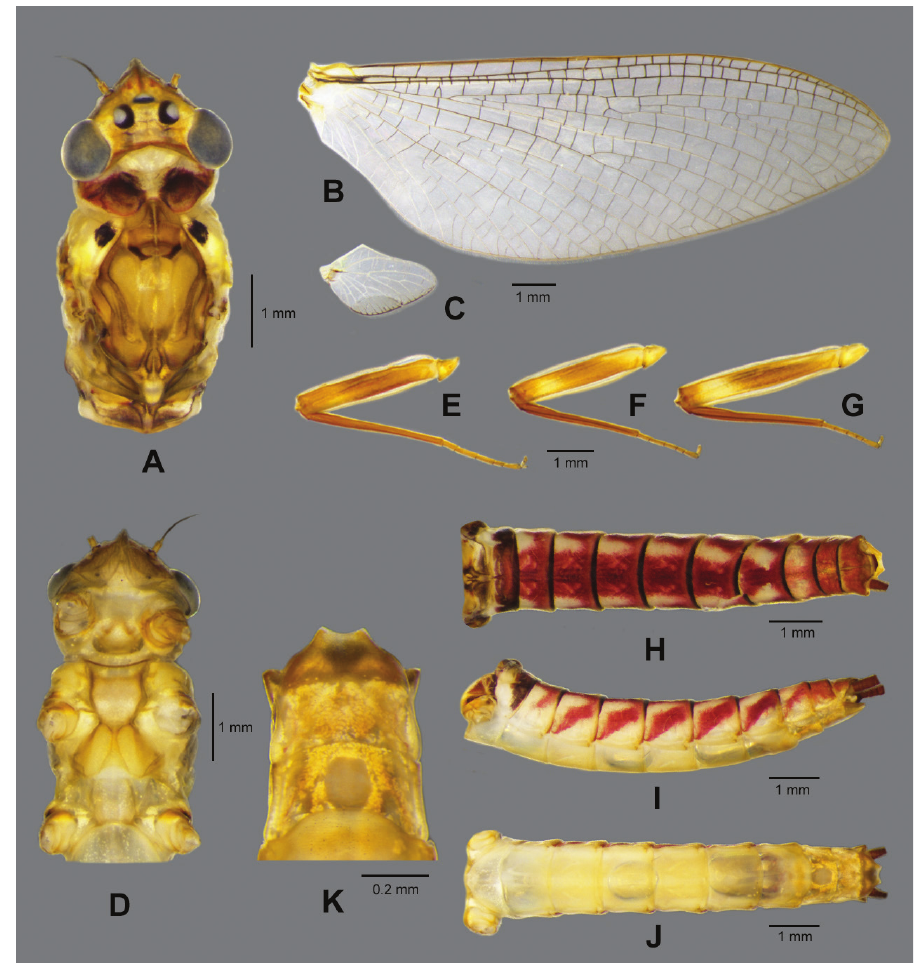
Figure 8. Paegniodes sapanensis sp. nov., female subimago A head and thorax (dorsal view) B forewing C hindwing D head and thorax (ventral view) E foreleg F middle leg G hind leg H abdomen (dorsal view) I abdomen (lateral view) J abdomen (ventral view) K genitalia (ventral Female subimago (in ethanol Fig. 8, living Fig. 10D, F) Body length 12.8 mm, cerci 20.0 mm, forewing 14.4 mm, hindwing 2.6 mm. Colouration (Fig. 8). Head, thorax and abdomen dorsally brown. Head, thorax and abdomen ventrally light brown. Legs yellow. Caudal filaments brown. Head (Fig. 8A). Compound eyes separated by 3.0× width of median ocellus. Thorax (Fig. 8A, D). Pronotum and mesonotum each with pair of dark dots, sternum light brown; forewings semitransparent, veins yellowish to brown (Fig. 8B); hindwings 0.18 the size of the forewings (Fig. 8C). Legs yellowish to yellowish brown; femora brown with proximal and distal light maculae; tibiae uniformly brown; foreti-